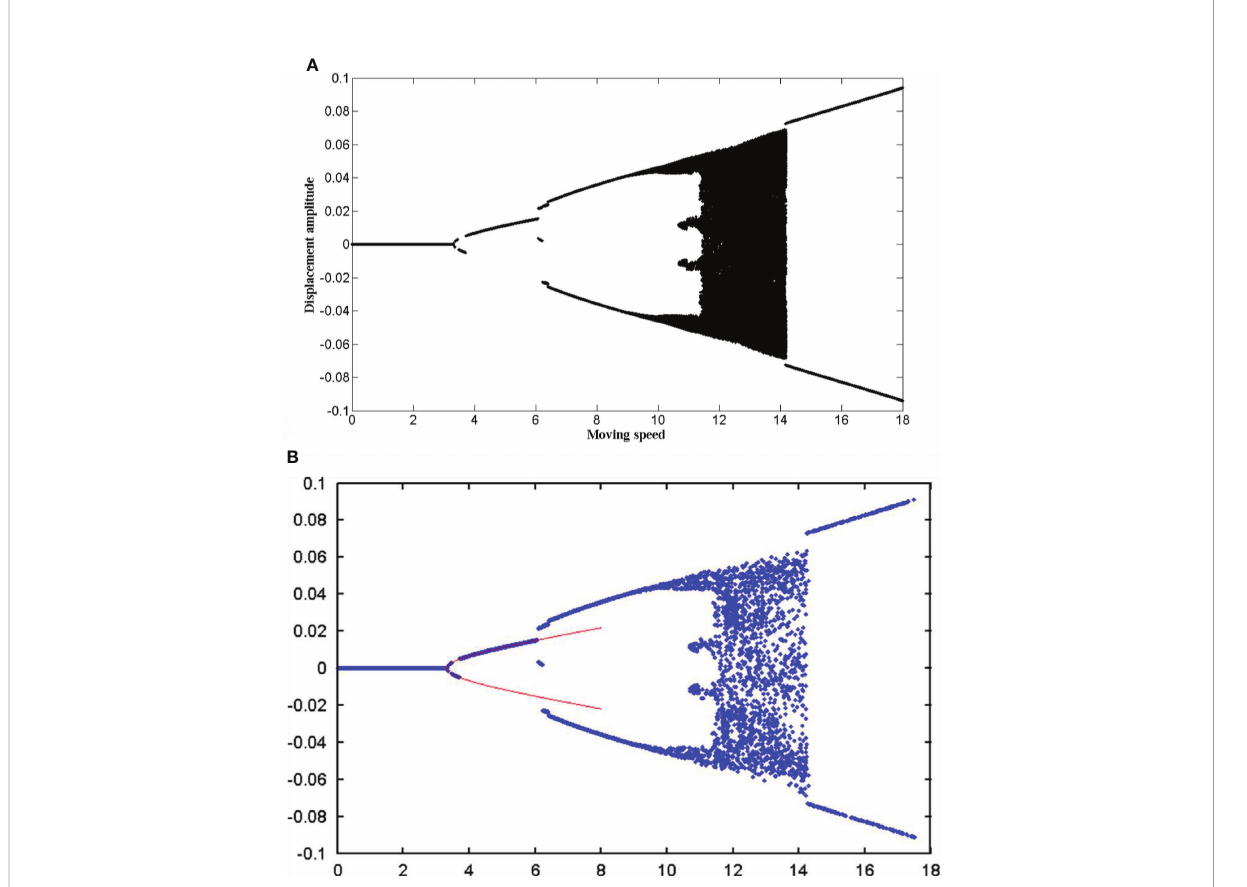
FIGURE 5 The bifurcation diagrams for the midpoint of the pipe, irrespective of the internal fl uid: (A) the present work; (B) Figure 2 in the work of Li and Ni (Li et al.,